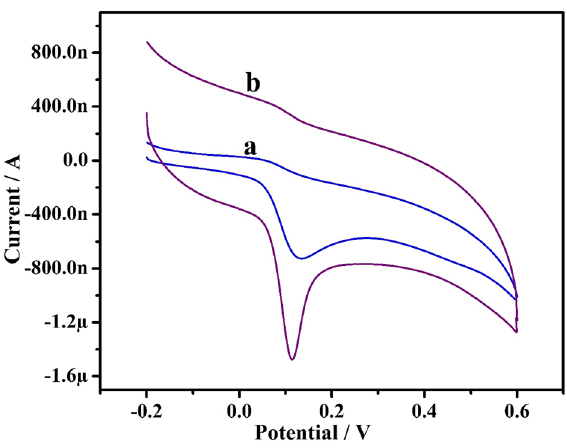
Figure 4. CVs of ADR in 0.2 M PBS (7.4 pH) at bare GPE (curve ‘ a ’) and Po-ERY/MGPE (curve ‘ b ’) at sweep rate of 50 mVs −1 .